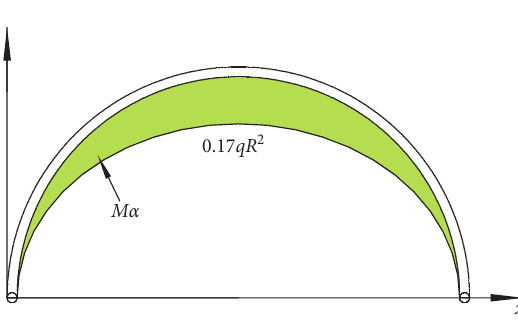
Figure 7: Bending moment of a semicircular